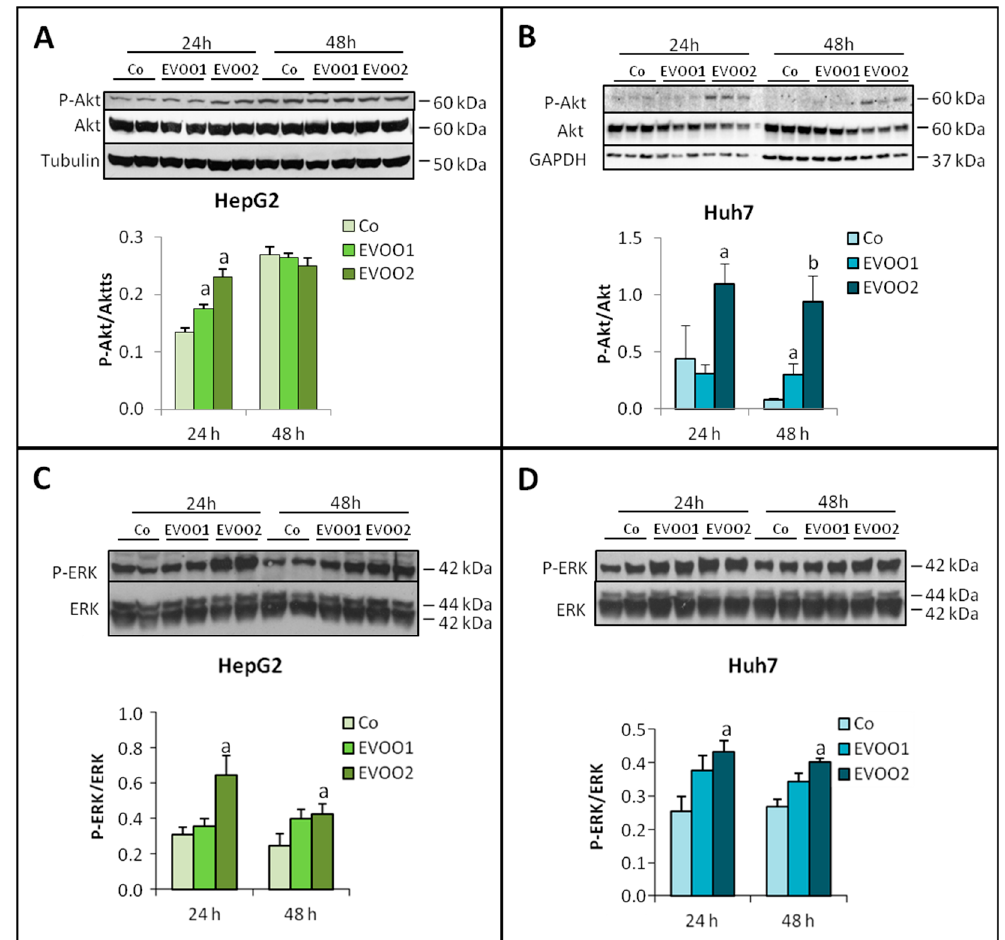
Figure 4. EVOO extract modulates the anabolic side of protein turnover. The cell lines were incubated for 24 and 48 h with two different doses of the phenolic extract. ( A , C ) Expression of P-Akt and P-ERK in HepG2 cell line. ( B , D ) Expression of P-Akt and P-ERK in Huh7 cell line. The results are representative of three experiments. The protein molecular weights are reported. Data are presented as mean ± SD. (a: p < 0.05, b: p < 0.01 versus Control).